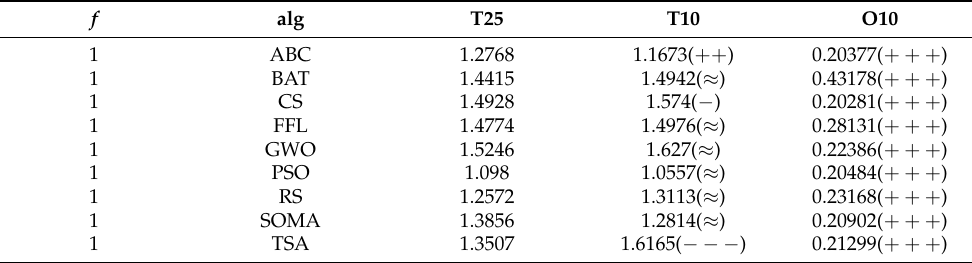
Table 18. The median values and significance of all algorithms from the Wilcoxon rank-sum